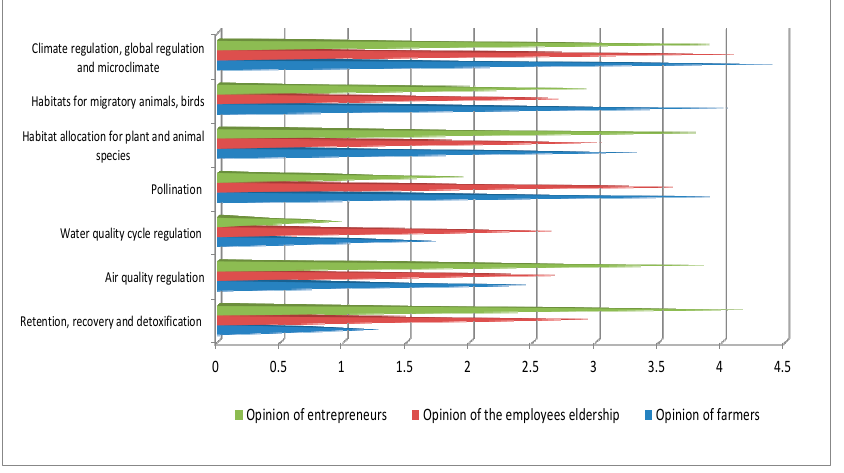
Figure 4. Respondents’ views on the future (2020–2030) potential of cultural ES, in score aver- ages.